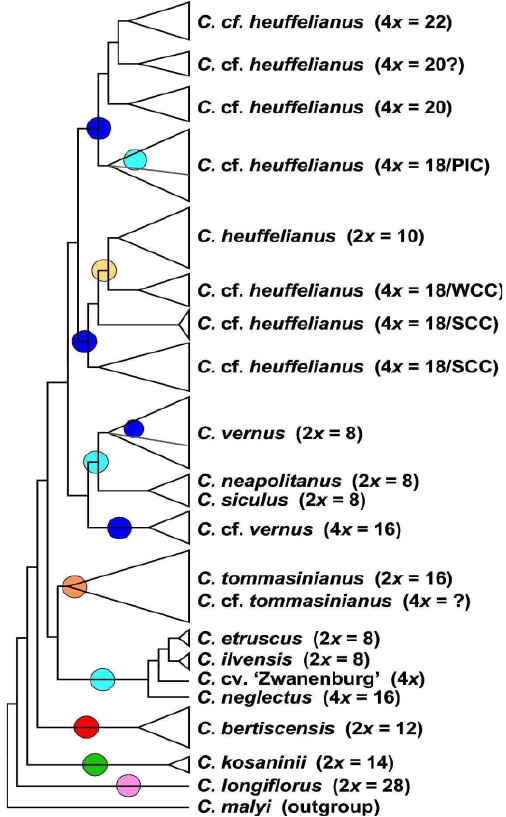
Figure 3. Schematic representation of the strict consensus tree topology of 5400 most parsimonious trees derived from an MP analysis of the GBS dataset including di- and tetraploid accessions of Crocus ser. Verni (for original data see Supplementary Figure S3). In brackets the ploidy levels and chromosome numbers are given. For tetraploids with 4 x = 18 the geographic affiliation is also provided, as Pannonian-Illyric Clade (PIC), Southern Carpathian Clade (SCC), and Western Carpathian Clade (WCC). Colored circles refer to the chloroplast types present in the respective clades (below).